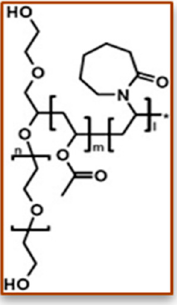
Figure 20. Structure of Soluplus ® .